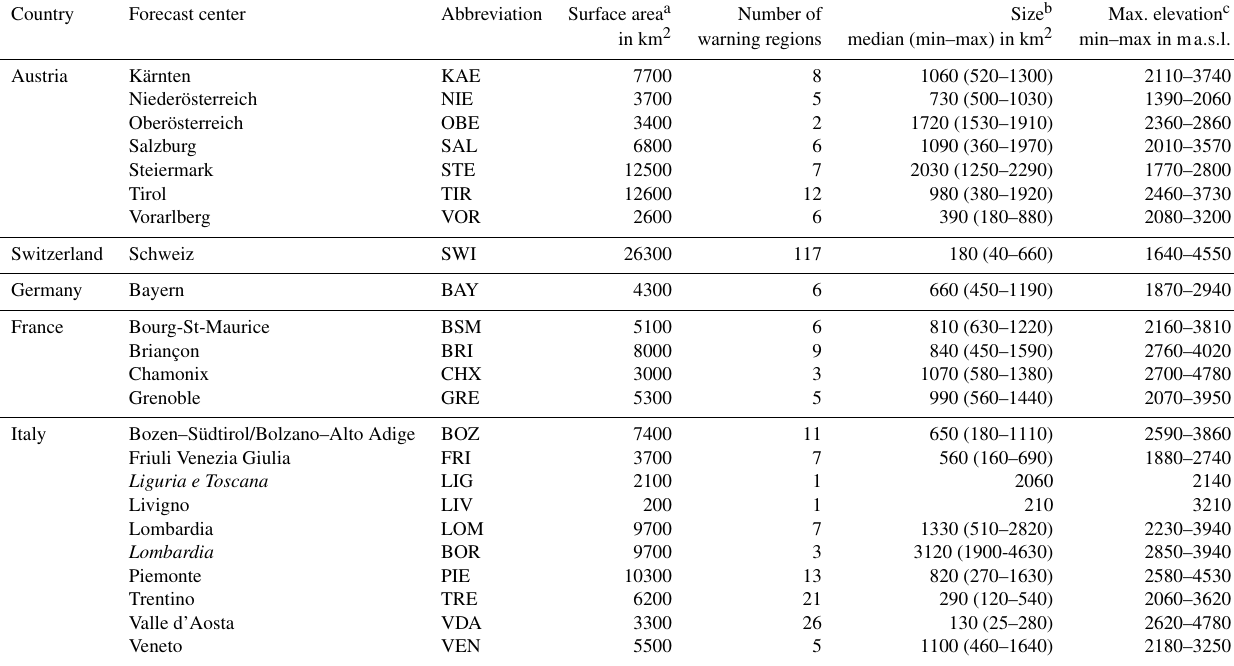
Table 2. Overview of the forecast centers considered in this study. Italian forecast centers refer to AINEVA, except those indicated in italic for Meteomont Carabinieri. Forecast centers and warning regions outside the Alps are not shown. Three-letter abbreviations indicate forecast centers. For countries, we use English names; for forecast centers, we use the names in their original language. Country Forecast